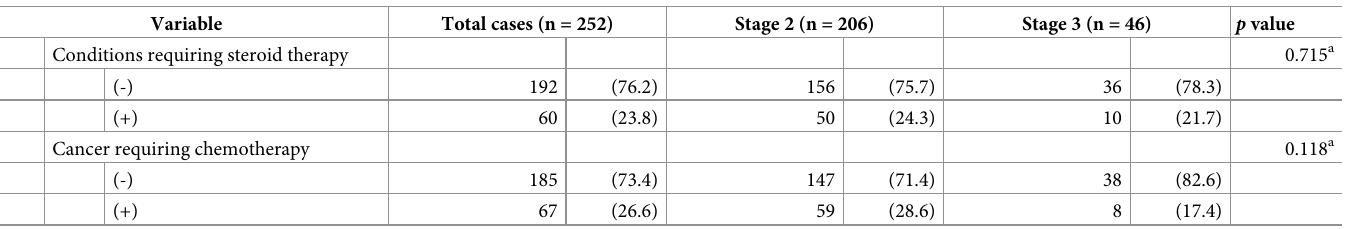
located in the mandible (n = 137, 54.4%), and the most frequent initiating event was tooth extraction (n = 114, 45.2%). Of the 252 patients, 138 (54.8%) underwent surgery and 143 (56.7%) received HBO therapy. There were 119 (47.2%) patients with osteoporosis and 133 (52.8%) with malignant disease. The most common type of ARONJ in this study was BRONJ (n = 206, 81.7%). Most patients continued ARA therapy (n = 213, 84.5%). The most frequent comorbidity was hypertension (n = 109, 43.3%). The percentage of patients with stage 3 ARONJ undergoing � 46 sessions of HBO therapy (n = 13, 28.3%) was higher than that of patients with stage 2 ARONJ (n = 18, 8.7%). The treatment outcome of patients with ARONJ is presented in Table 2. A total of 139 patients (55.2%) were healed. Of the 138 patients who underwent surgery, and the 143 patients who received HBO therapy, 116 (84.1%) and 97 (67.8%) patients were healed, respectively. The healing rate of patients with stage 3 ARONJ (n = 23, 50.0%) was lower than that of patients with stage 2 ARONJ (n = 116, 56.3%). The treatment outcome of patients who underwent a combination of surgery and HBO therapy is presented in Table 3. Of the 109 patients, 105 underwent HBO therapy before and after surgery, of which 88 (83.8%) were healed. In patients undergoing both surgery and HBO therapy, the healing rate for stage 3 ARONJ (n = 20, 87.0%) was higher than that for stage 2 ARONJ (n = 70, 81.4%). Univariable analysis showed strong associations between treatment outcomes and sex ( p = 0.045), anatomic location ( p = 0.023), surgery ( p < 0.001), HBO therapy ( p < 0.001), indication for ARA ( p < 0.001), ARA type ( p = 0.001), hypertension ( p = 0.002), and can- cer requiring chemotherapy ( p < 0.001) in stage 2 ARONJ. In stage 3 ARONJ, strong asso- ciations between outcomes and surgery ( p < 0.001), indication for ARA ( p = 0.001), and ARA type ( p = 0.016) were observed. Healing was not observed in patients who did not undergo surgery (Table 4). Multivariable logistic regression showed that healed status was associated with conservative surgery (OR, 14.046; 95% CI, 4.035–48.897; p < 0.001), extensive surgery (OR, 51.830; 95% CI, 11.481–233.983; p < 0.001), � 46 sessions of HBO therapy (OR, 0.121; 95% CI, 0.019–0.782; p = 0.027), and indication for ARA (OR, 0.229; 95% CI, 0.075–0.695; p = 0.009) in stage 2 ARONJ. In stage 3 ARONJ, variables of surgery could not be selected as covariates because of the number of events, whereas healed status was associated with indication for ARA (OR, 0.145; 95% CI, 0.034–0.544; p = 0.004) (Table